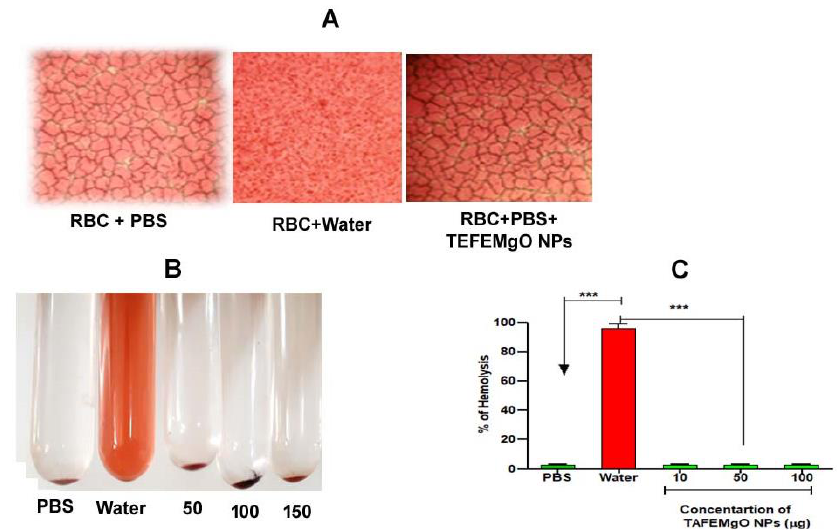
Figure 9. Direct hemolytic assay: ( A ) microscopic image of TAFEMgO NPs-protected RBC, ( B ) pictorial representation of TAFEMgO NPs depicting RBC hemolytic assay. ( C ) The % of hemolysis was determined at 540 nm as the measured amount of released Hb. *** Significance at p ≤ 0.0001.